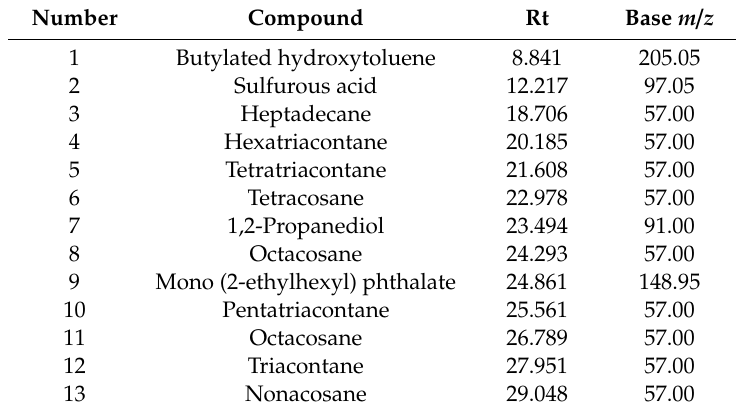
Table3. Activepreservativecompoundsfrom Hypneamusciformis (HM)identifiedusingGC-MSanalysis.